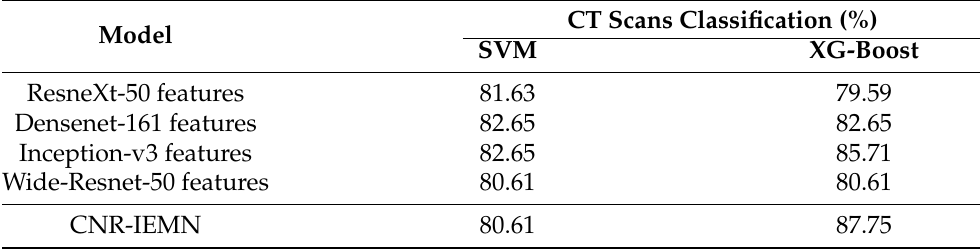
Table 5. Validation CT scan classification results using SVM and XG-boost with different group- ing percentages’ features (ResneXt-50, Densenet-161, Inception-v3, and Wide-Resnet-50 grouping percentages features) and their combination [6].